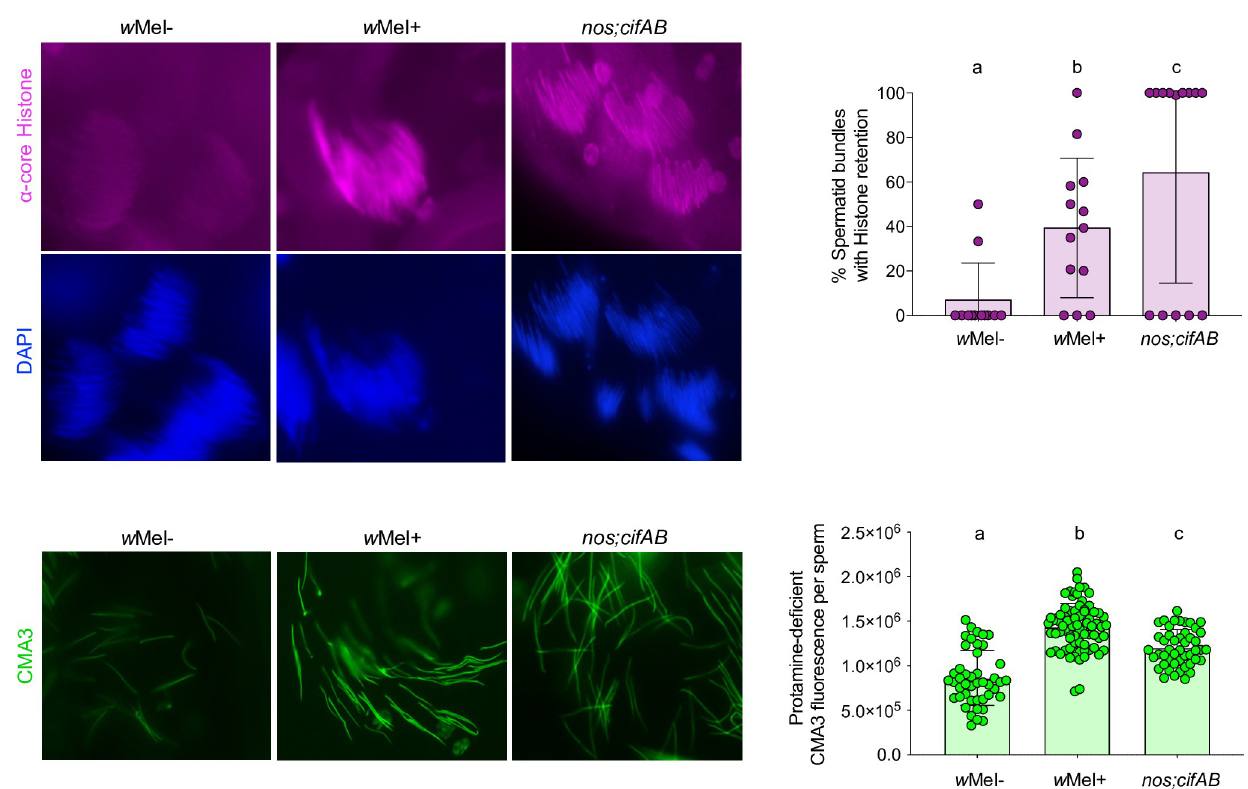
Fig 2. Cifs cause histone retention in late canoe spermatids and protamine deficiency in mature sperms. (A) Testes ( n = 15) from < 8-hour-old males of w Mel+, w Mel − , and transgenic cifAB lines were dissected and immunostained to visualize and quantify spermatid bundles with histone retention (purple) during late canoe stage of spermiogenesis. DAPI stain (blue) was used to label spermatid nuclei. Total spermatid bundles with DAPI signals and those with retained histones were manually counted and graphed. Compared to the negative control w Mel − , w Mel+ Wolbachia and dually expressed cifAB transgenic lines show abnormal histone retention in the late canoe stage. Vertical bars represent mean, and error bars represent standard deviation. Letters indicate statistically significant ( p < 0.05) differences as determined by pairwise comparisons based on Kolmogorov–Smirnov test. (B) Mature sperms isolated from seminal vesicles ( n = 15) of < 8-hour-old males reared at 21˚C were stained with fluorescent CMA3 (green) for detection of protamine deficiency in each individual sperm nucleus. Individual sperm head intensity was quantified in ImageJ (see Methods) and graphed. w Mel+ and transgenic cifAB lines show enhanced protamine deficiency levels compared to w Mel − control. Vertical bars represent mean, and error bars represent standard deviation. Letters indicate statistically significant ( p < 0.05) differences as determined by multiple comparisons based on a Kruskal–Wallis test and Dunn multiple test correction. All of the p -values are reported in S1 Table. The experiments were performed in 2 independent biological replicates and samples were blind-coded for the first run. Raw data underlying this figure can be found in S1 Data file. CMA3, chromomycin